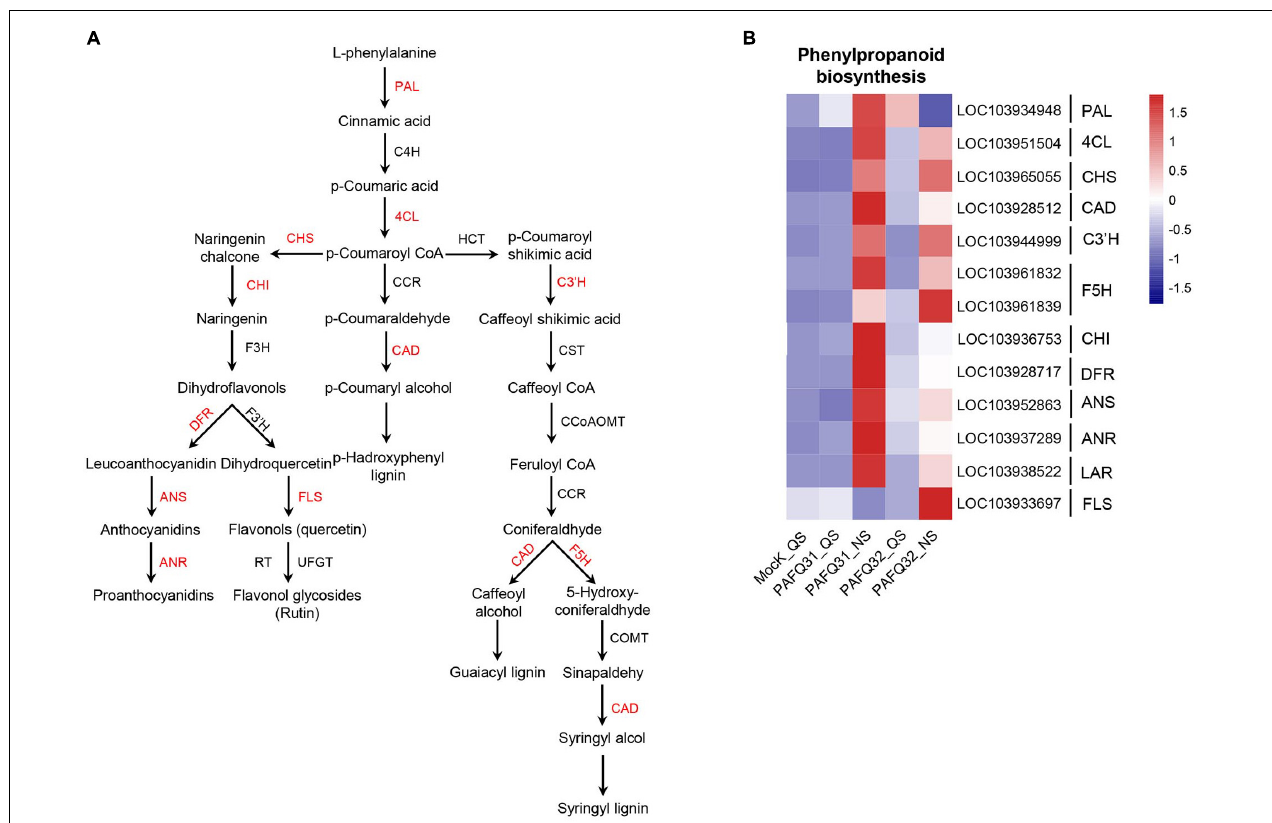
FIGURE 5 | Heatmap analyses of the DEGs related to phenylpropanoid metabolism pathway in P. pyrifolia leaves in response to the infection of each C. fructicola strain. (A) Simplified diagram of phenylpropanoid metabolism pathway, with red color indicating the upregulated genes. (B) Expression profiles of the DEGs related to phenylpropanoid metabolism